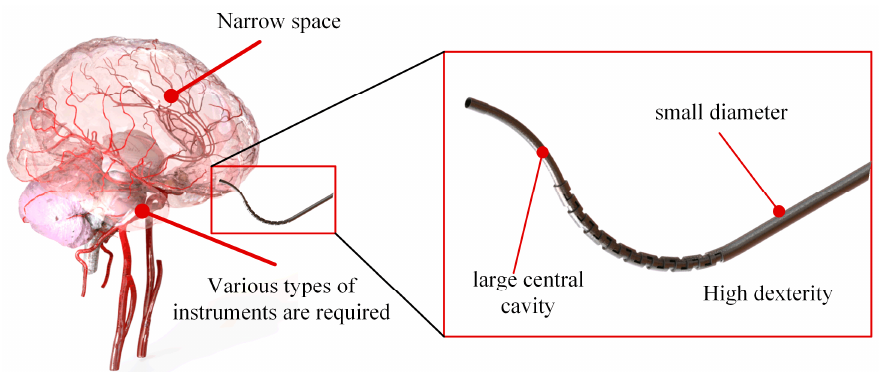
Figure 2. Requirements for surgical instruments in surgery.